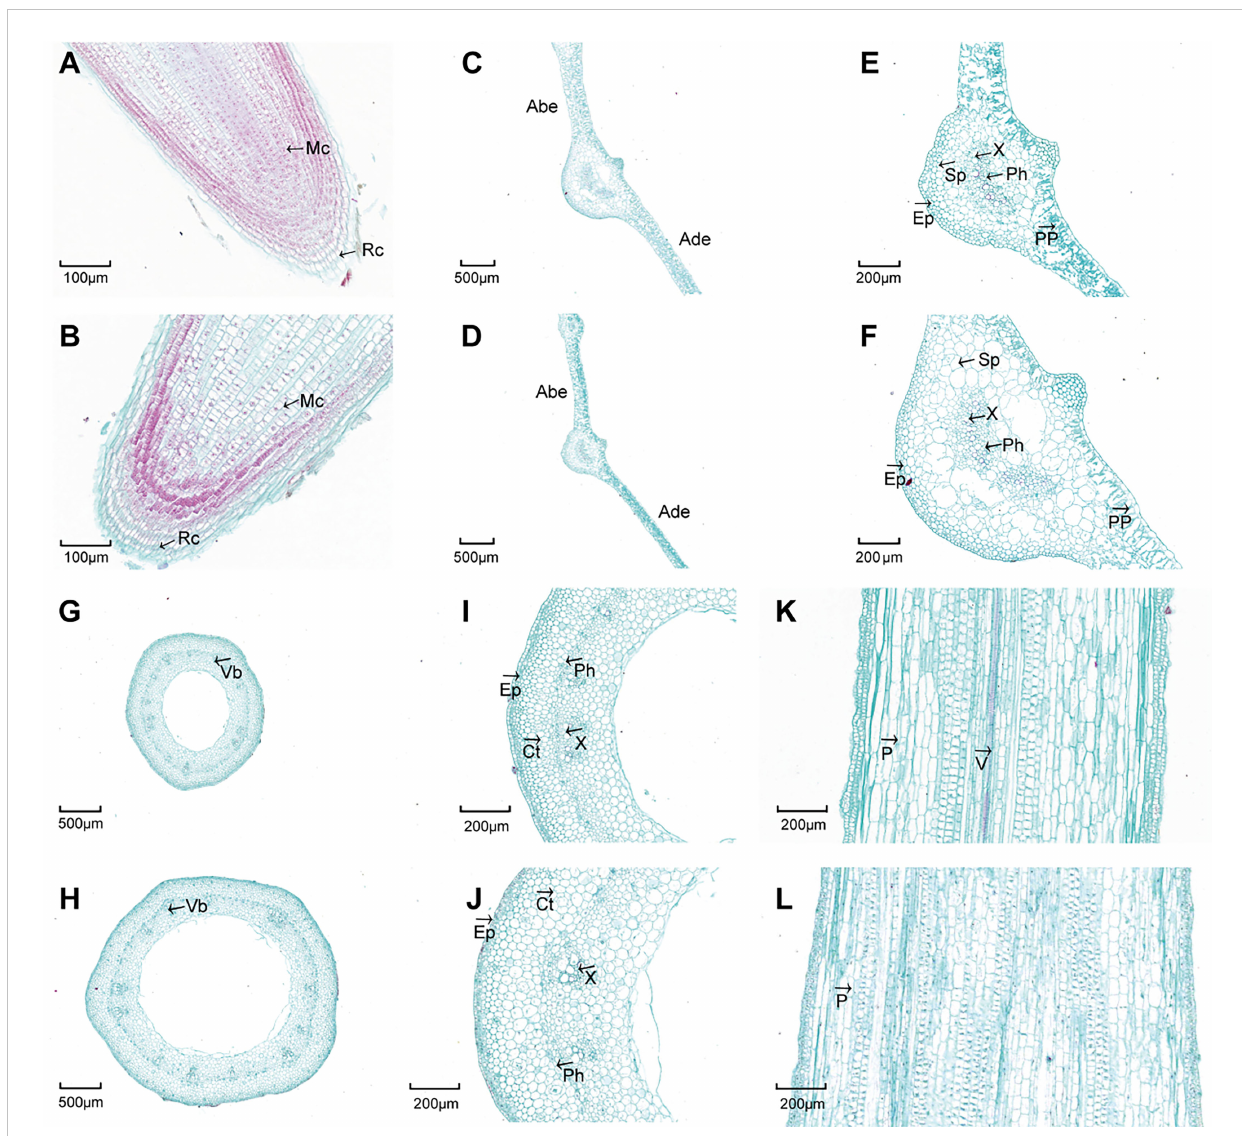
FIGURE 2 Histological observations between diploid and colchicine treated water spinach. (A) Longitudinal-section of 2X water spinach root tips. (B) Longitudinal- section of colchicine treated water spinach root tips. (C) Cross-section of 2X water spinach leaf (×2.0). (D) Cross-section of colchicine treated water spinach leaf (×2.0). (E) Cross-section of 2X water spinach leaf (×6.0). (F) Cross-section of colchicine treated water spinach leaf (×6.0). (G) Cross-section of 2X water spinach stem (×2.5). (H) Cross-section of colchicine treated water spinach stem (×2.5). (I) Cross-section of 2X water spinach stem (×5.0). (J) Cross-section of colchicine treated water spinach stem (×5.0). (K) Longitudinal-section of 2X water spinach stem. (L) Longitudinal-section of colchicine treated water spinach stem. (Rc, Root cap; Mc, Meristome cells; Ade, Adaxial epidermis; Abe, Abaxial epidermis; PP, Palisade parenchyma;